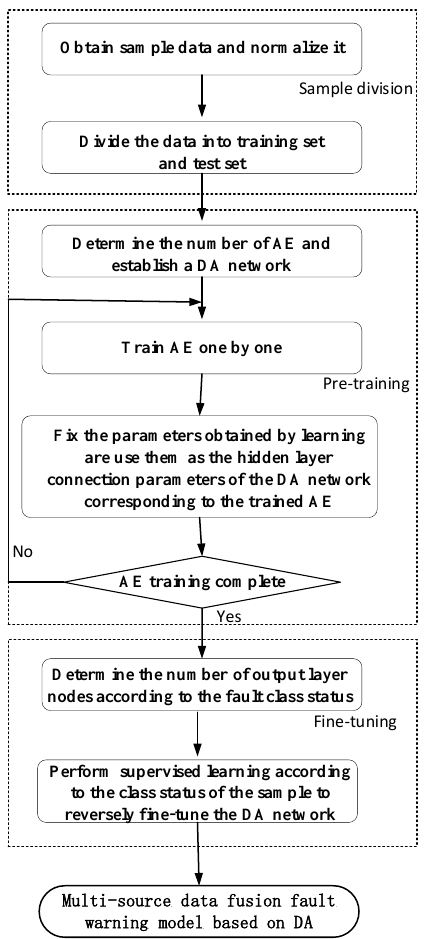
Figure 5. Process of generating DA-based fault diagnosis model.